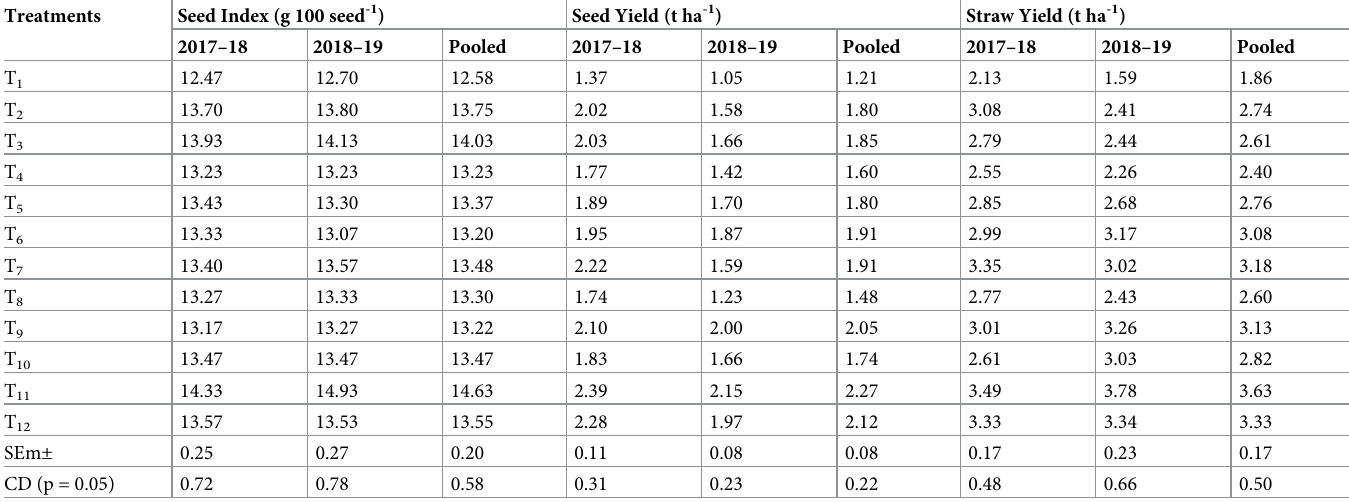
Table 3. Chickpea seed index, seed and straw yield.